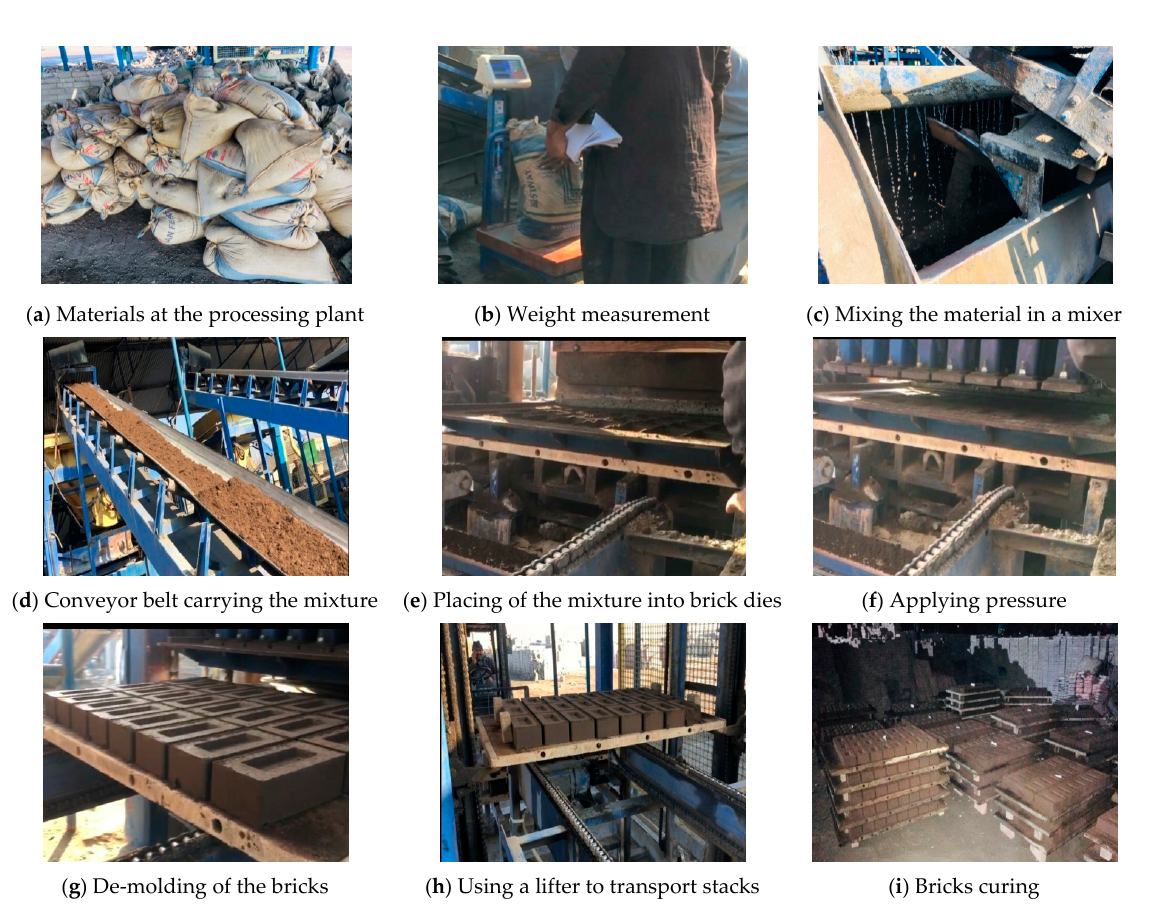
Figure 2. The casting process of coal-ash compressed bricks.